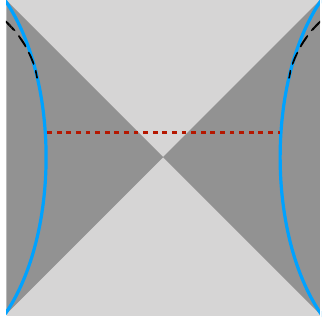
Figure 4 . The 2-sided, uncoupled setup. At some later time, we can insert some matter, which kicks the Schwarzian